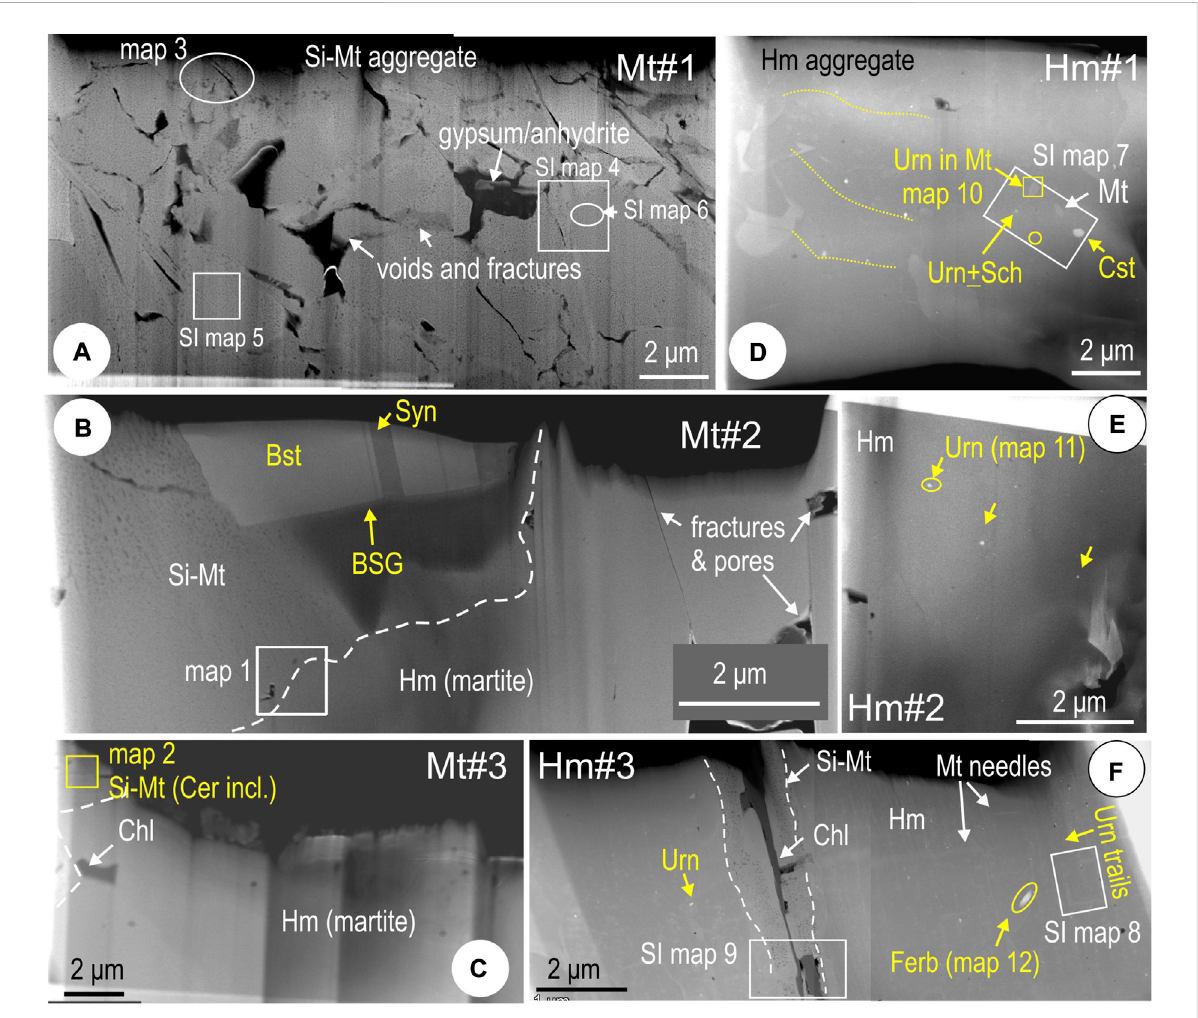
FIGURE 3 HAADF STEM images providing overview of thinned foils from sample CLC21. (A) Foil Mt#1. (B) Foil Mt#2. (C) Foil Mt#3. (D) Foil Hm#1. (E) Foil Hm#2. (F) Foil Hm#3. BSG, bastnäsite-synchysite group minerals; Bst, bastnäsite; Cer, cerianite; Chl, chlorite; Cst, cassiterite; Ferb, ferberite; Hm, hematite; Mt, magnetite; Sch, scheelite; Si-Mt, silician magnetite; Syn, synchysite; Urn, uraninite. White boxes refer to areas of element maps in this